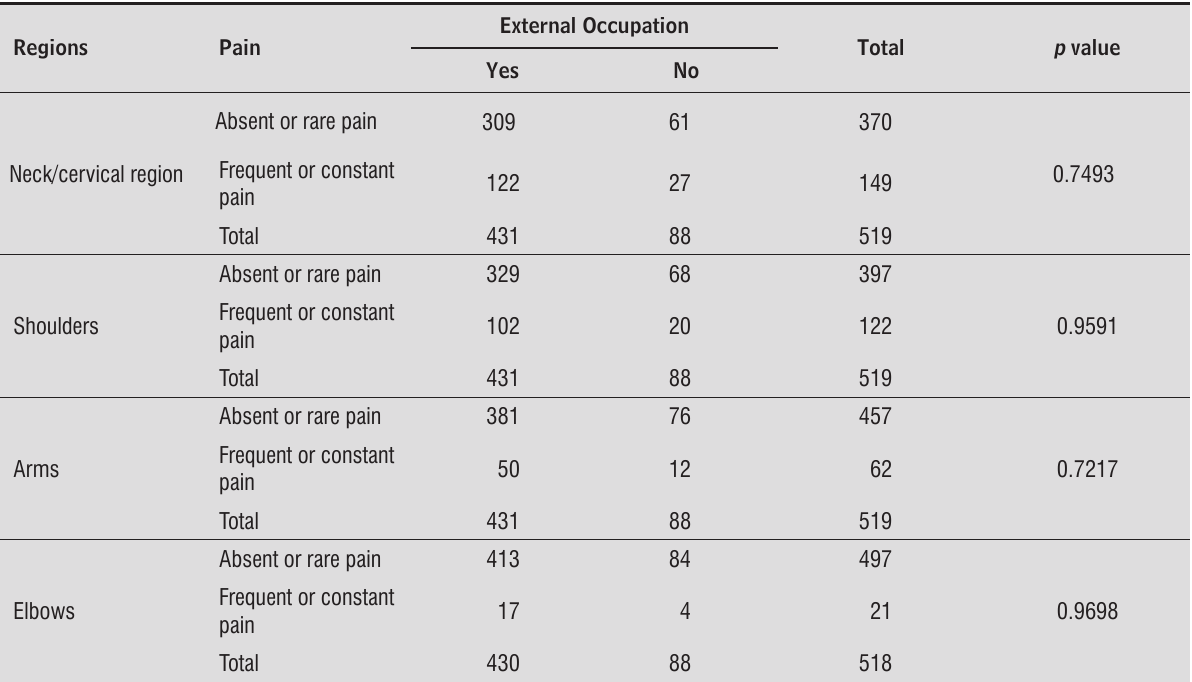
Table 3 - Presence of pain and performance of other professional activities of Unifal-MG staff (Campus I, Alfenas, Minas Gerais, Brazil)